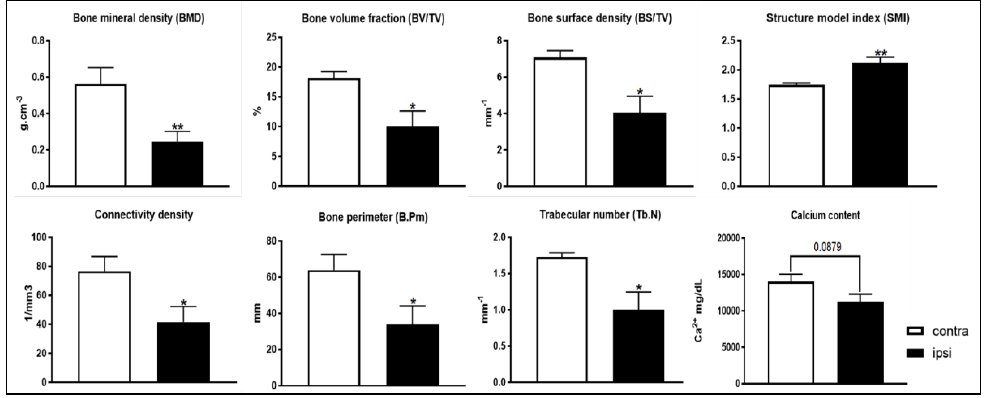
Figure 13. Bone structural parameters and calcium 4 weeks after surgery. Analyzed bone parameters were lower in ipsilateral tibia of CCI rats; the structure model index was higher; and the bone calcium content showed a decreasing trend. The results are expressed as mean ± S.E.M. *: p < 0.05, **: p < 0.01 vs. contralateral.